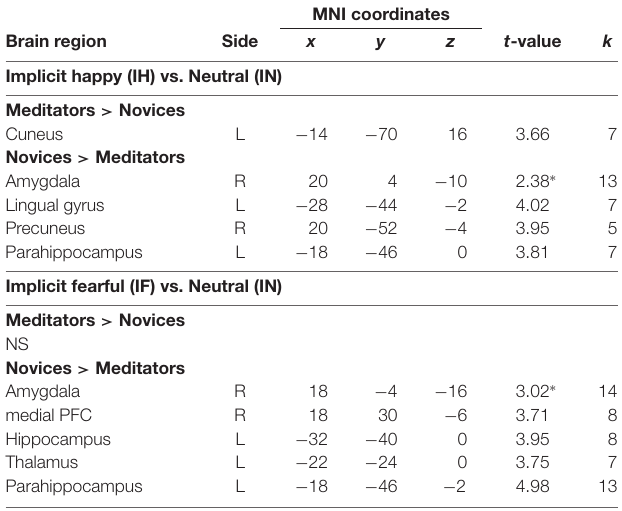
TABLE 3 | Group-wise fMRI results to implicit emotional processing.